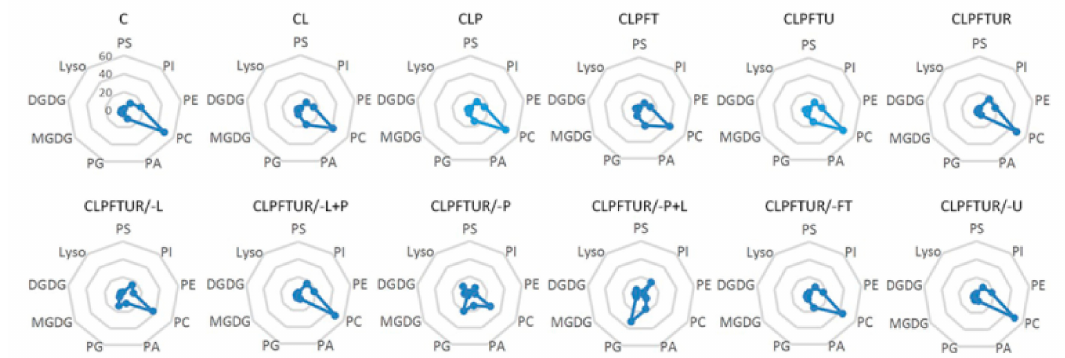
Figure 4. Molecular percentages of lipid classes in Magnolia officinalis ECs after cryopreservation treatments. Twelve different treatments (see Figure 1 legend for notation) were examined and compared. Values are means of n = 5.